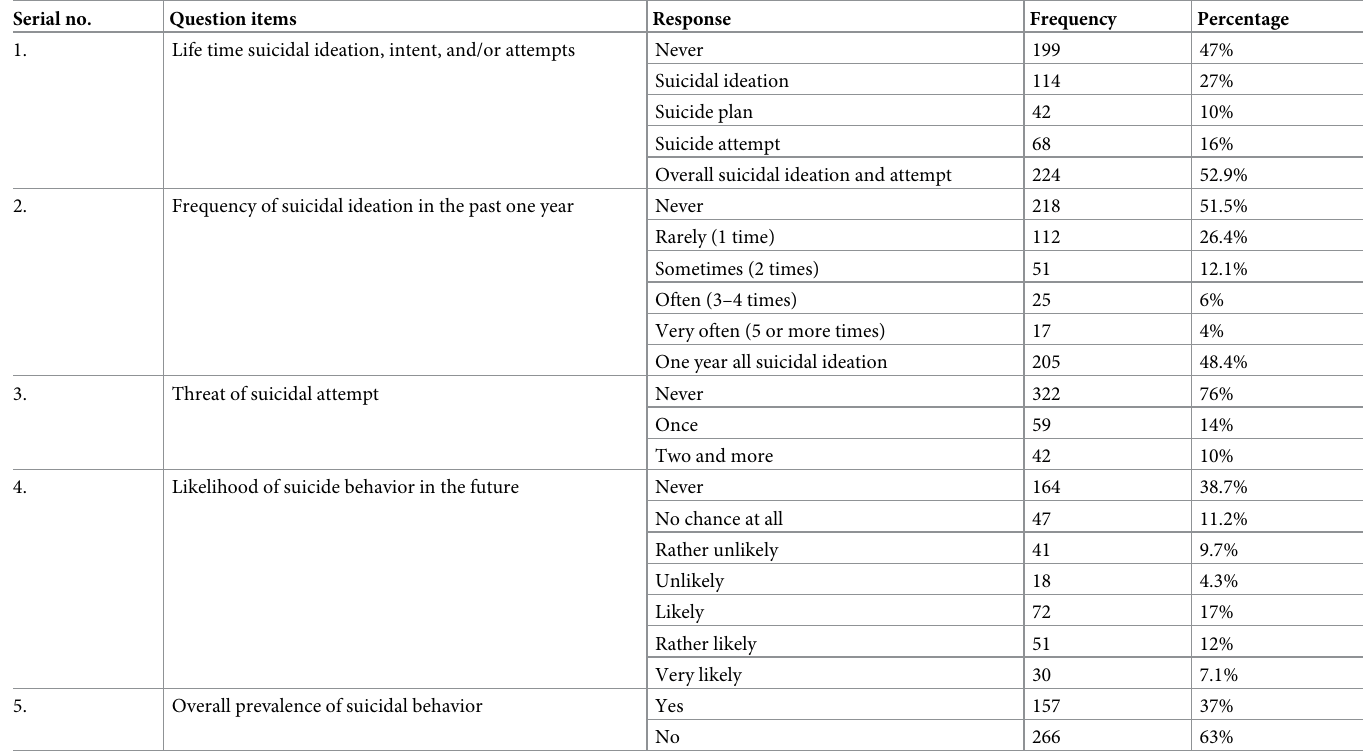
Table 1. Suicidal behavior items response of respondents Dec, 2020 (N = 423). Serial